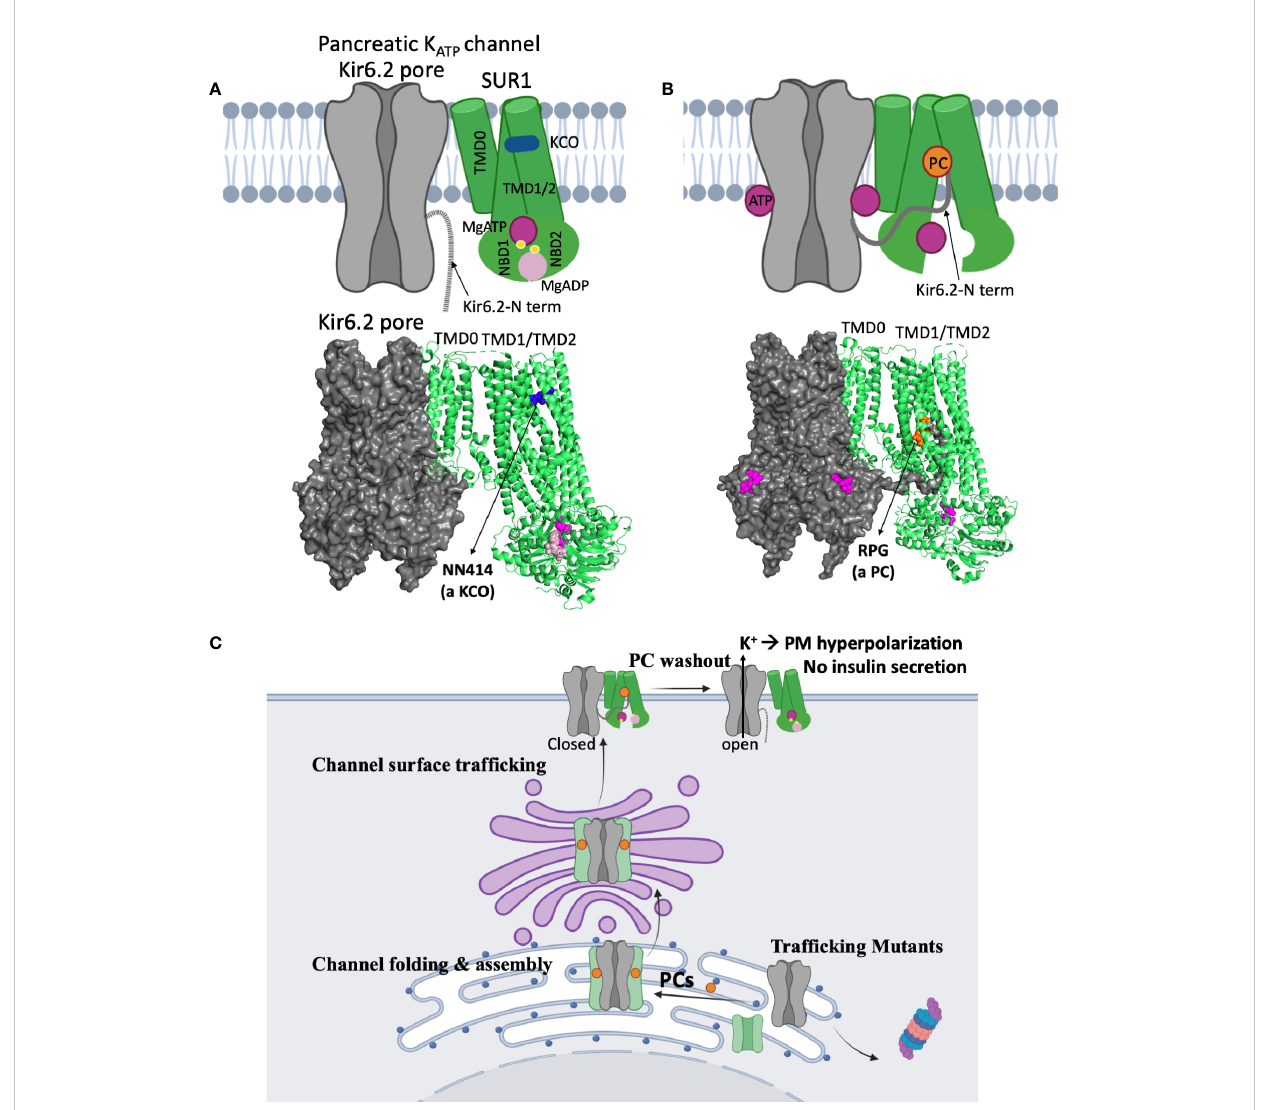
FIGURE 4 Structural insights on the mechanisms of K ATP channel pharmacological modulators. (A) A cartoon model ( top ) illustrating the mechanism by which potassium channel openers (KCOs) stimulate channel activity, based on a recent structure of a channel bound to MgATP/MgADP and a KCO NN414 shown below (PDB ID: 7W4O; only one SUR1 subunit shown for clarity). In the structure, the SUR1 NBD1 and NBD2 are bound to MgATP and MgADP respectively and dimerized, a conformation that stimulates channel activity. NN414, which binds at a transmembrane domain pocket